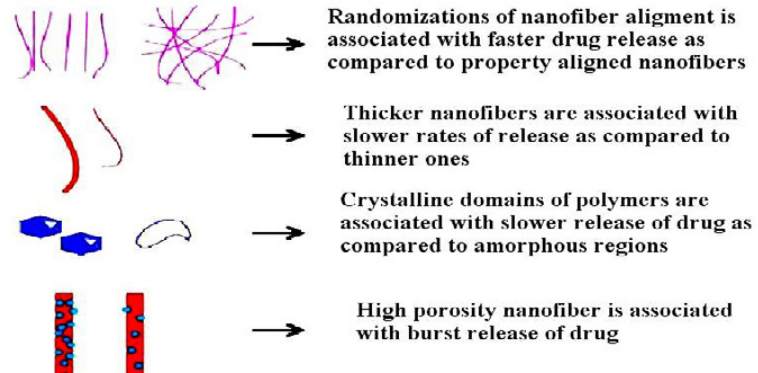
Fig. 3. Scheme of interactions between drug and Nano-fibers.